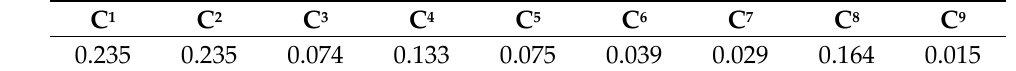
Table 5. Eigenvector—Criteria’s weights.